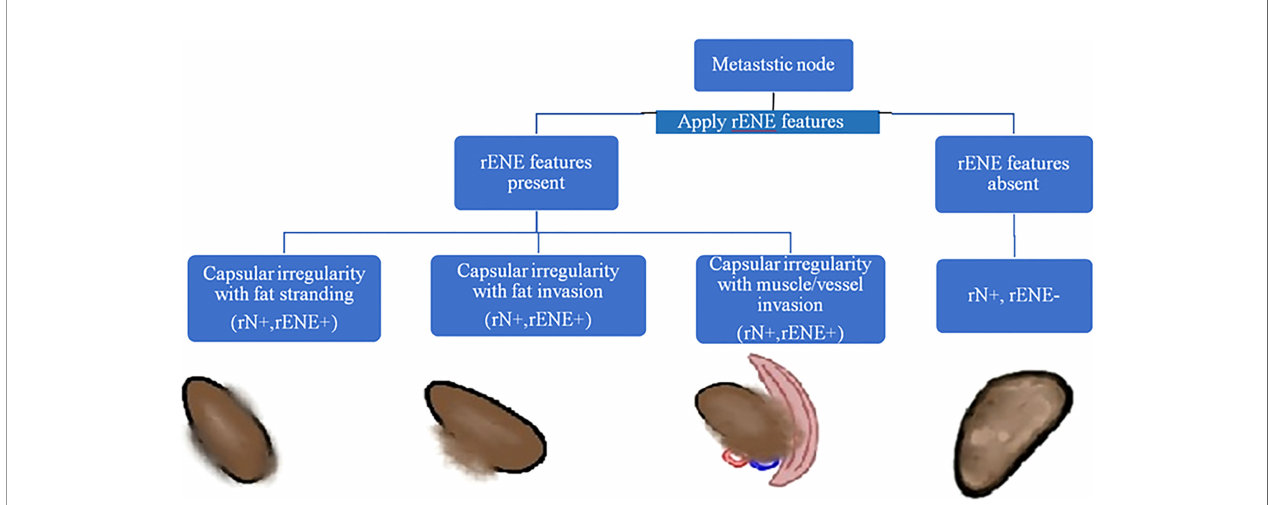
FIGURE 3 | Algorithm to determine ENE positive/negative status. Node with the presence of any one of the three features, namely, capsular irregularity with fat stranding, capsular irregularity with fat invasion, or capsular irregularity with gross muscle/vessel invasion, was considered ENE